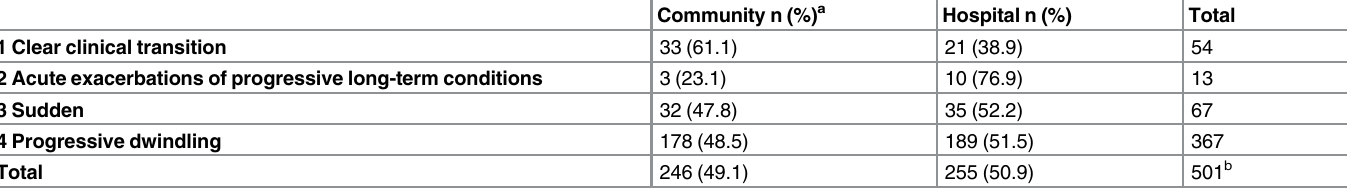
Table 3. Community vs. hospital and trajectory to death.